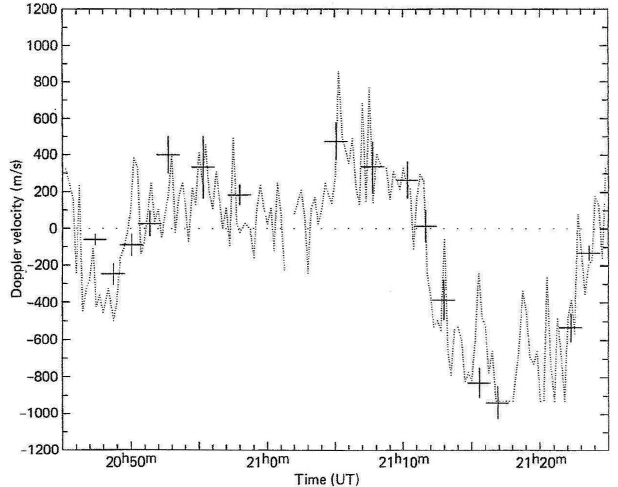
Figure 6. Comparison of plasma drift measurements obtained with the Sondrestrom ISR and irregularity drift measurements obtained with the Goose Bay HF Radar. The radars were looking toward each other, so the sign of the Goose Bay measurement has been reversed. Details of this comparison are given in the text and in Ruohoniemi et al. (1987). In brief, the dotted line shows Sondrestrom Doppler measurements, with 15s integration time, while the crosses show the average Goose Bay Doppler velocity measured on beams 10 and 11. Goose Bay values are only plotted if acceptable data were ob- tained on both beams. The timing errors on the crosses are assumed to be 10s, which is the time interval that the radar is dwelling on beams 10 and 11. Note that the width of the timing error bars has been enhanced by a factor of 10. Reproduced from Fig. 9 of Ruo- honiemi et al.